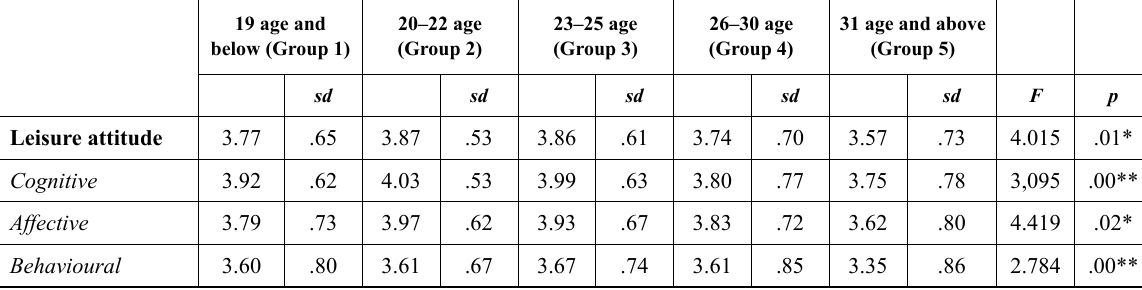
Table 3. Leisure Attitude Levels of the Participants by the Variable of Age